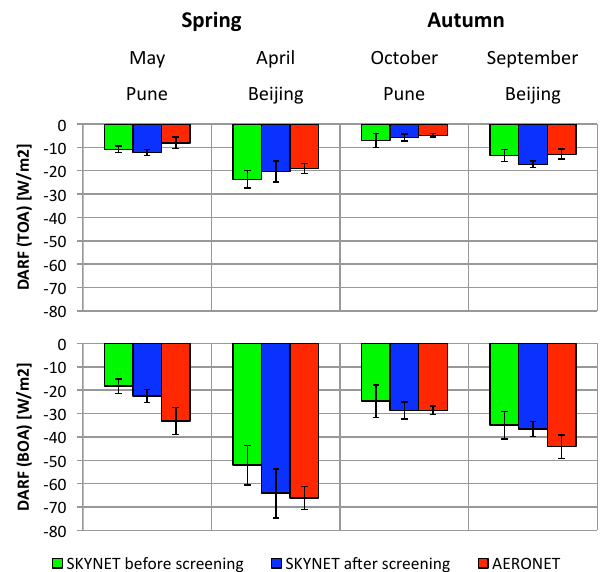
Fig. 16. Seven-day back trajectories on 11 May 2008, 12:00:00UTC at Pune from the AERONET web site (NASA, http://croc.gsfc.nasa.gov/aeronet/).